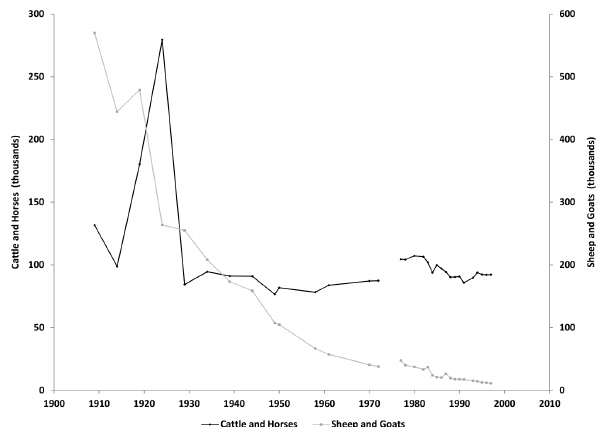
Figure 9. Grazing permits on national forests of New Mexico granted by the United States Forest Service from 1909 to 1997 (Source: USDA – Forest Service, 1991 and